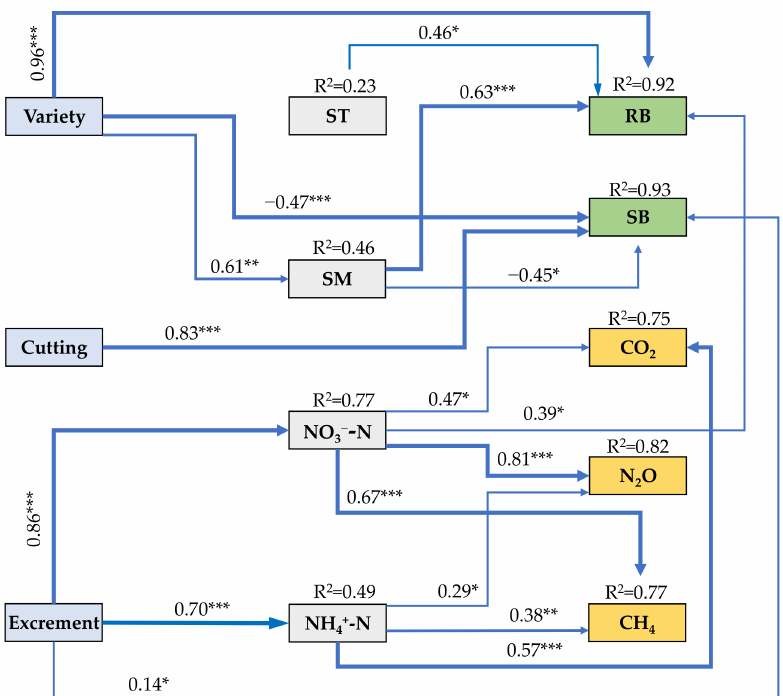
Figure 7. Structural equation model based on data in this study. The structural equation model shows the direct and indirect effects of soil and biomass factors on CO 2 , CH 4 , and N 2 O emissions. The number at each arrow is the normalized path coefficient with significance levels indicated as *** p < 0.001; ** p < 0.01, and * p < 0.05. The R 2 value above the variables represents the proportion of variance in the interpretation of endogenous variables ( χ 2 = 1.967; degrees of freedom (df) = 12; p =